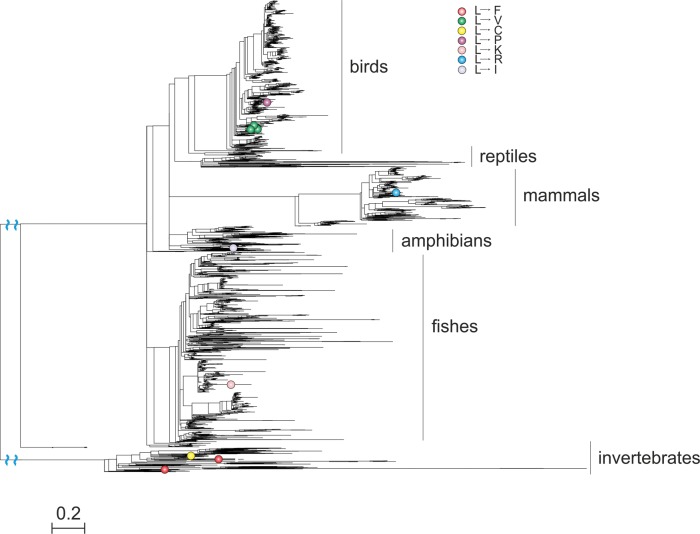
Parallel and divergent substitutions at site 202 of ATP6 (NCBI reference sequence numbering for the human sequence). The ancestral variant (L) has experienced multiple substitutions, which are scattered throughout the phylogeny. However, the two parallel L→F substitutions occur in closely related species; the same is true for the three parallel L→V substitutions. Phylogenetic distances are in numbers of amino acid substitutions per site. The branches indicated with the blue waves are shortened by 1.2 distance units.